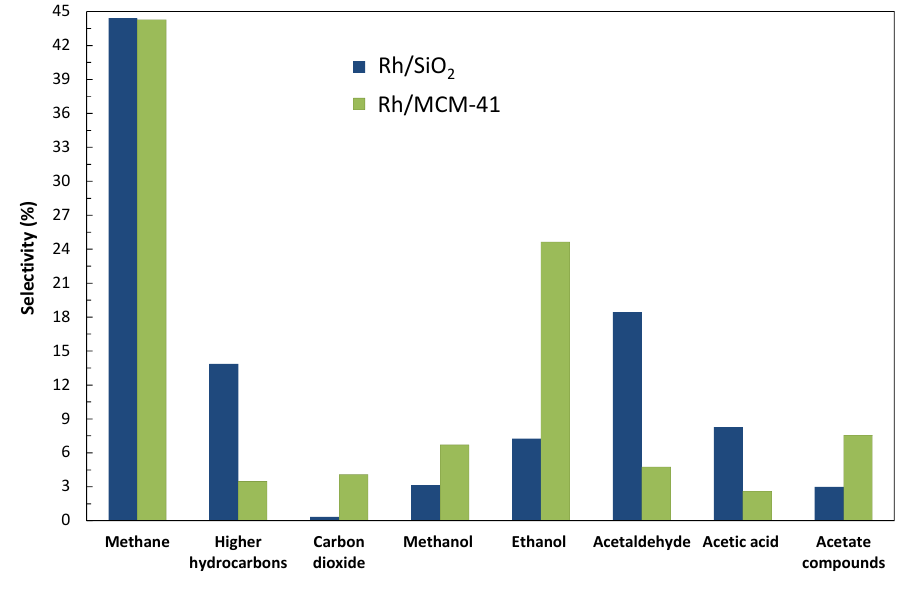
Figure 1. Product selectivities obtained from the conversion of syngas over Rh/SiO 2 and Rh/MCM-41. Higher hydrocarbons: ethane, propane and butane. Acetate compounds: methyl acetate and ethyl acetate. Reaction conditions: 280 °C, 20 bar, GHSV = 12,000